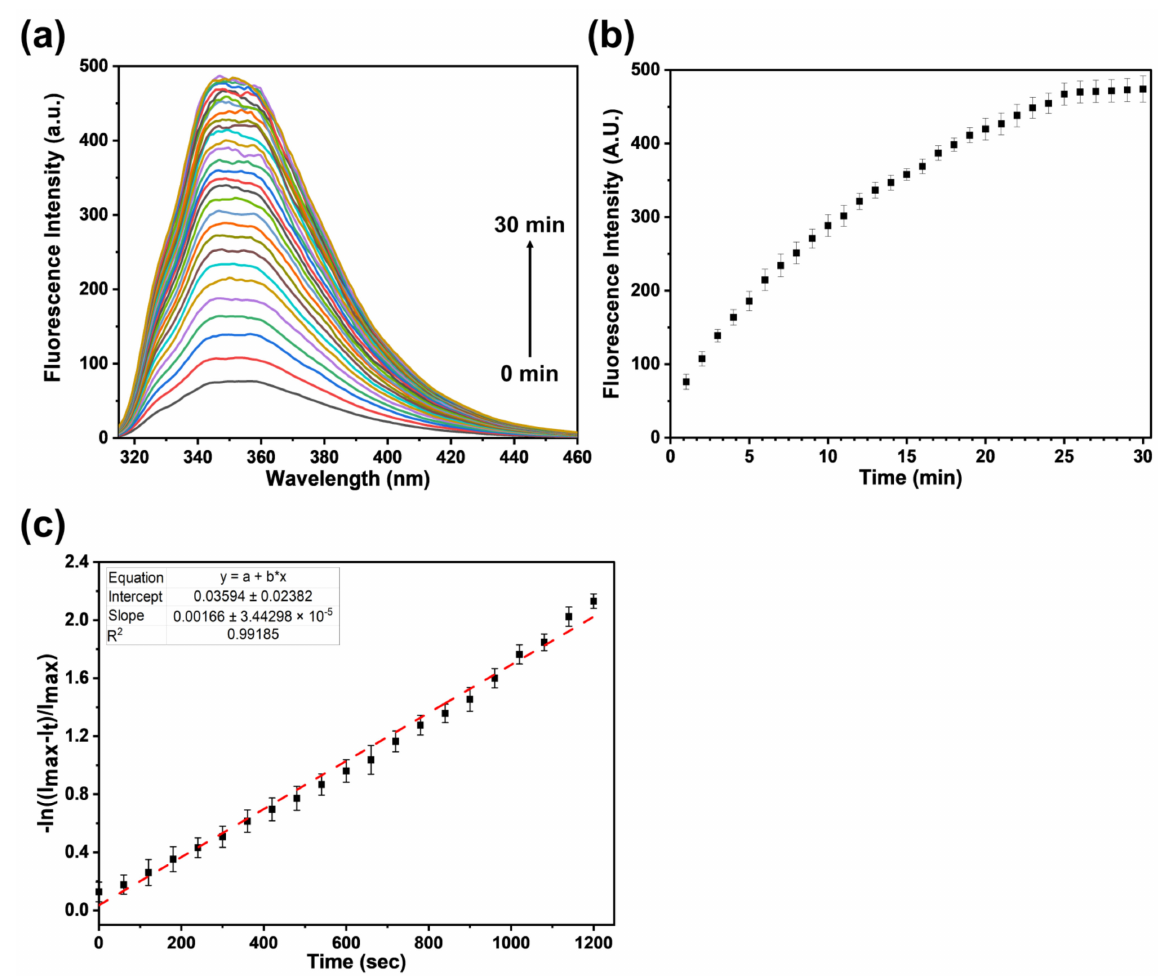
Figure 5. ( a , b ) Time-dependent fluorescence response and ( c ) pseudo-first-order kinetics plot for reac- tion of A-B (10 µ M) with Cys (50 µ M) in 0.01 M HEPES buffer solution (>0.1% DMSO) ( λ ex = 303 nm, λ em = 350 nm) at room